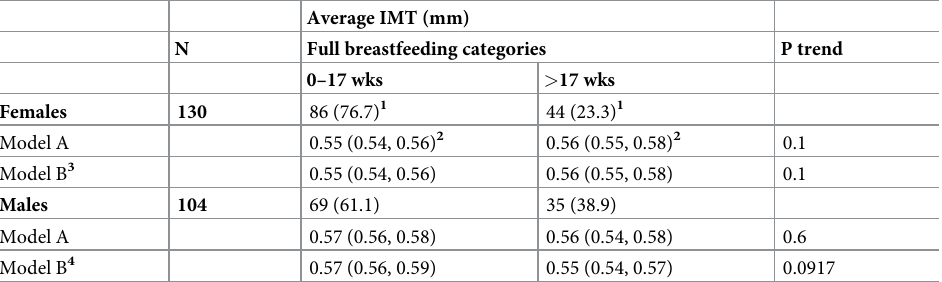
Table 2. Association of full breastfeeding categories and IMT in young adulthood among females and males. Average IMT (mm) N Full breastfeeding categories P trend 0–17 wks > 17 wks Females 130 86 (76.7) 1 44 (23.3) 1 Model A 0.55 (0.54, 0.56) 2 0.56 (0.55, 0.58) 2 0.1 Model B 3 0.55 (0.54, 0.56) 0.56 (0.55, 0.58) 0.1 Males 104 69 (61.1) 35 (38.9) Model A 0.57 (0.56, 0.58) 0.56 (0.54, 0.58) 0.6 Model B 4 0.57 (0.56, 0.59) 0.55 (0.54, 0.57) 0.0917 Average IMT: average of means of right and left side intima media thickness (IMT). Linear trends (P trend) were obtained in linear regression models with IMT as a continuous variable. 1 Values are frequencies (percentages) of breastfeeding durations. 2 Values are adjusted least squares means (95% Confidence Interval (CIs)) of IMT. Model A adjusted for adult age at IMT measurement and the physician taking the IMT measurement. 3 Model B among females additionally adjusted for birth year (residuals of birth year were calculated on age at IMT measurement) and maternal age at child birth. 4 Model B among males additionally adjusted for birth year (residuals of birth year were calculated on age at IMT